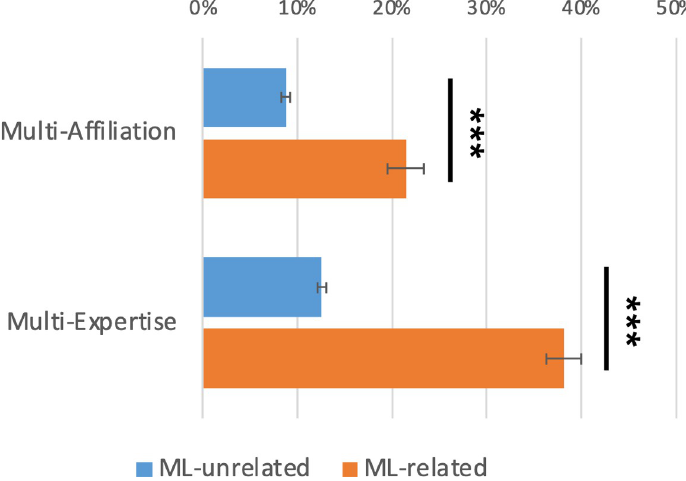
Fig 3. Interdisciplinary expertise. Collaboration forms are estimated by logit regressions controlling for publication years and journals. The error bars indicate one standard error. Two-tailed test: ��� p < 0.001.